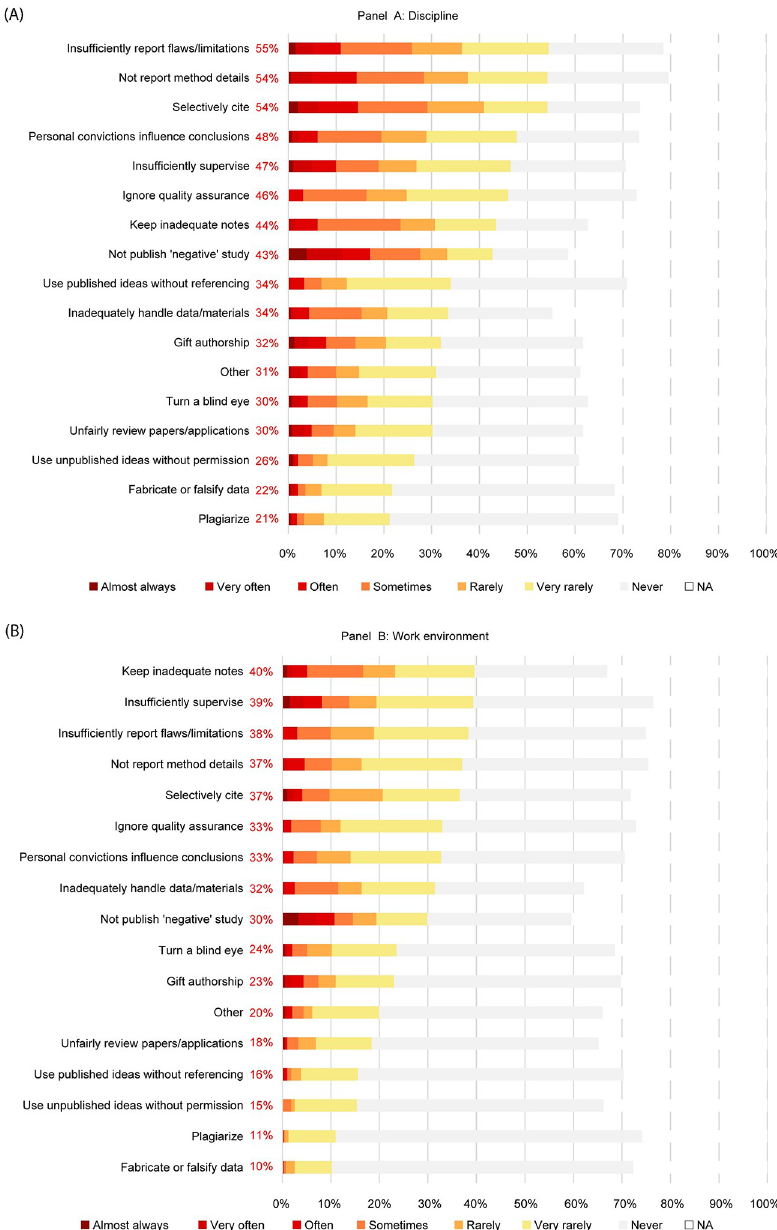
Fig 3. Estimated Prevalence of Questionable Research Practices, in the discipline (panel A) and the work environment (panel B). Note : Item descriptions were shortened for this figure. Full descriptions are in Table 8. Numbers in red are rate of respondents reporting occurrences “very